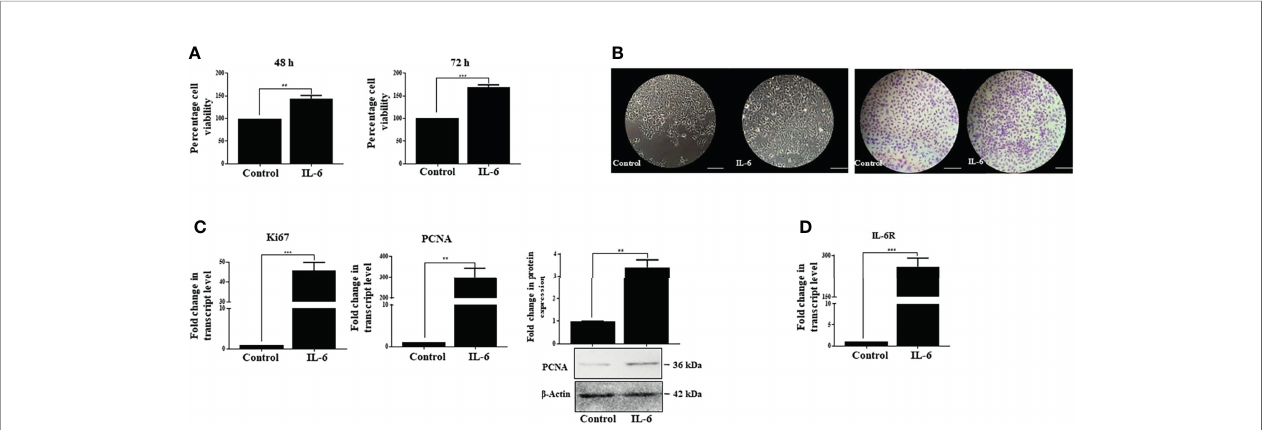
FIGURE 2 | IL-6 induces pro-proliferative effects in Huh-7 cells. (A) Analysis of cell viability after 48 or 72 h post-IL-6 (25 ng/ml) exposure. (B) Phase-contrast and crystal violet stained images of untreated or IL-6-treated (25 ng/ml) cells at 72 h (scale bar: 100 m m). (C) Transcript levels of Ki67 and PCNA and protein level of PCNA after IL-6 treatment (25 ng/ml) for 72 h (D) The transcript level of IL-6R after IL-6 treatment for 72 h. ** and *** refers to p value signi fi cance of ≤ 0.01 and ≤ 0.001